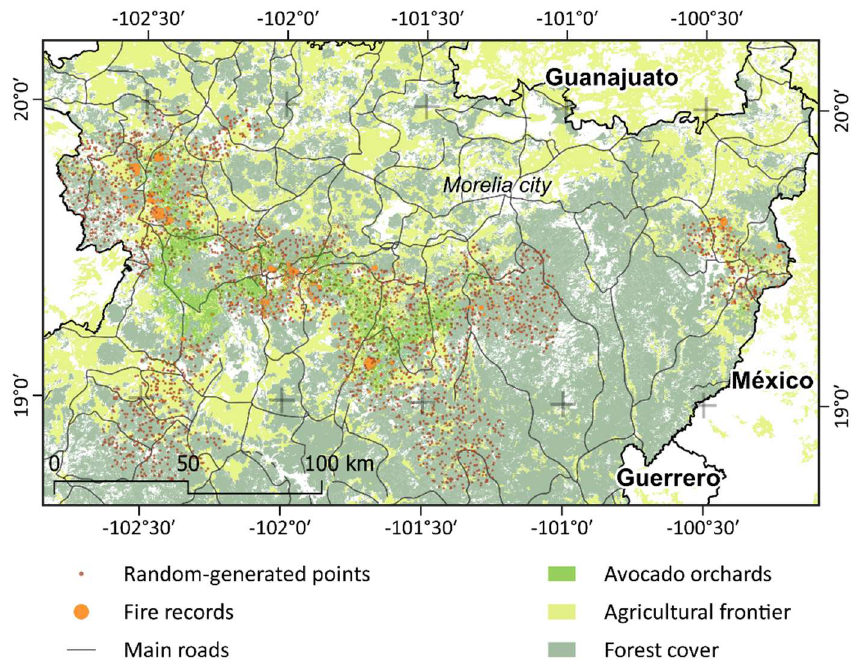
Figure 4. The random points and fire centroids were used for the distance analysis.